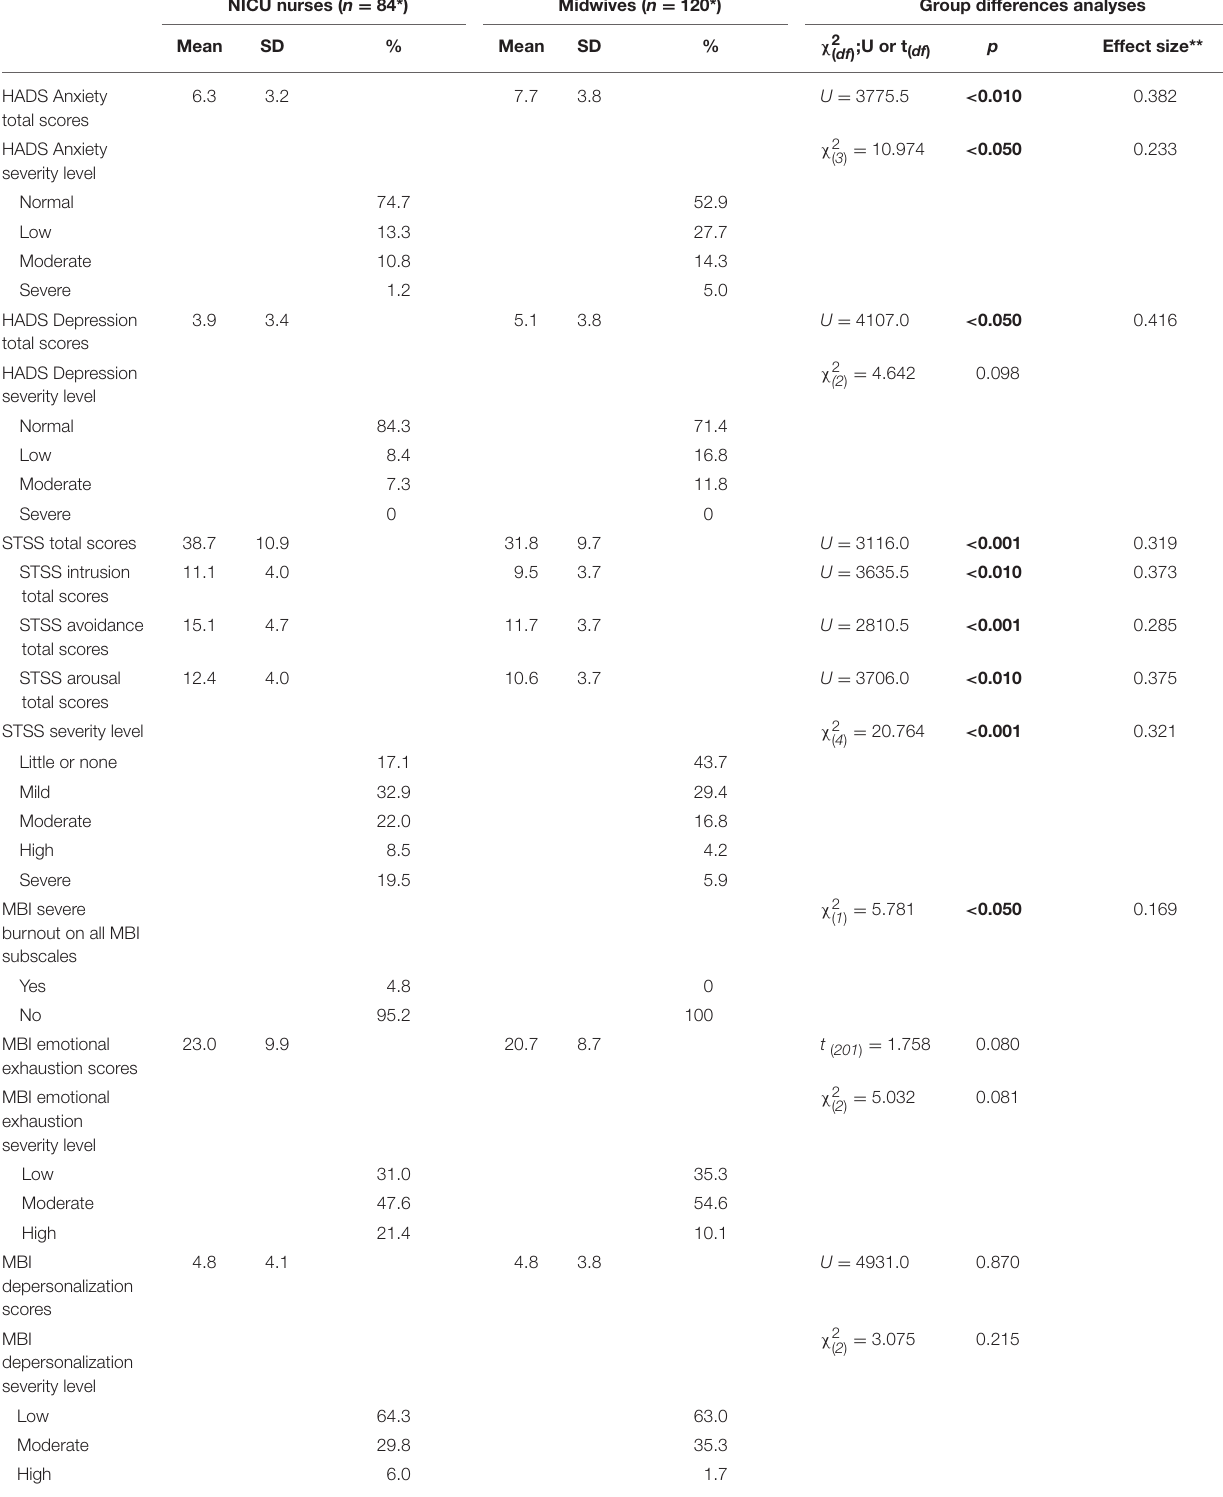
TABLE 2 | Mean scores and standard deviations of psychopathological symptoms and group comparisons. NICU nurses ( n = 84*) Midwives ( n = 120*) Group differences analyses